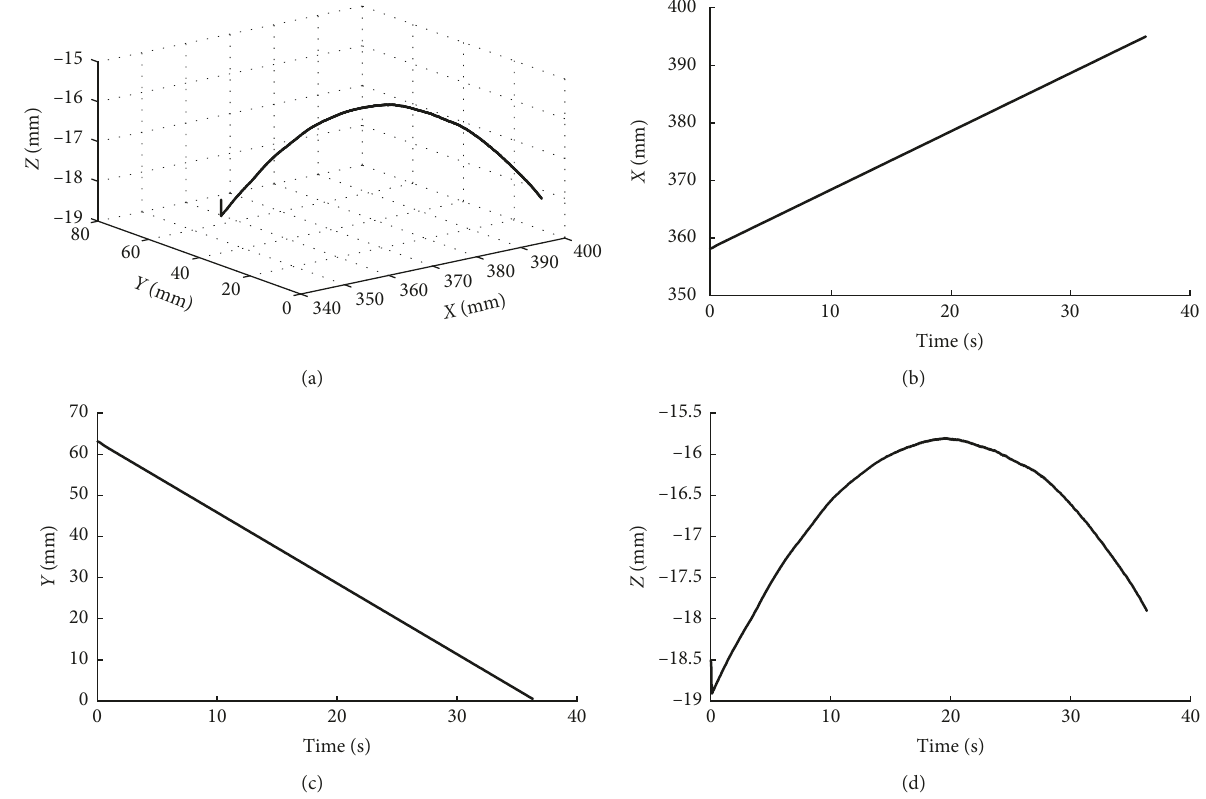
Figure 12: Curved planning trajectory relative to the base coordinate system. (a) 3D view of the curved trajectory. (b) X component of the curved trajectory. (c) Y component of the curved trajectory. (d) Z component of the curved